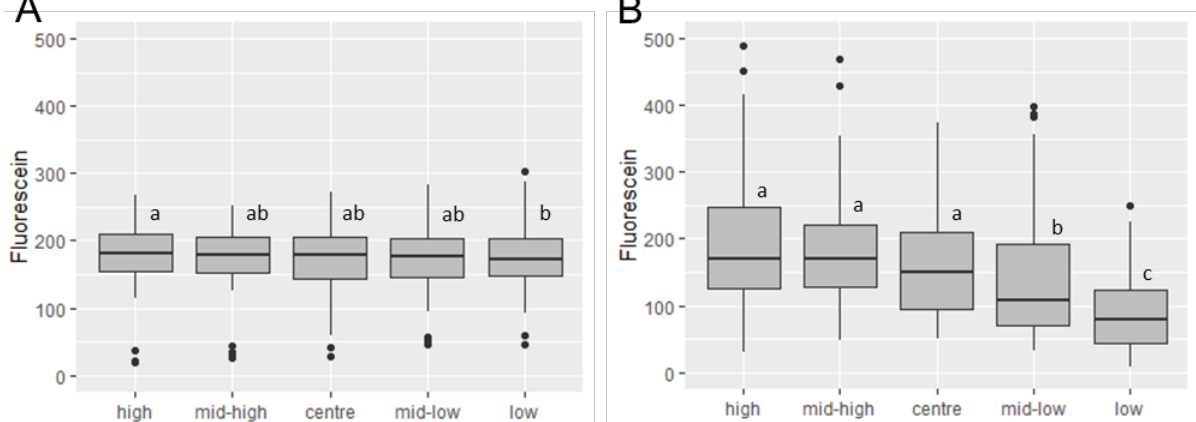
Figure 5. Wall height analysis for track and manual spray with fluorescein. ( A ) Track spray stratified by height with no overlap; ( B ) Manual spray stratified by height with no overlap. Significant differences are indicated by different lowercase letters.